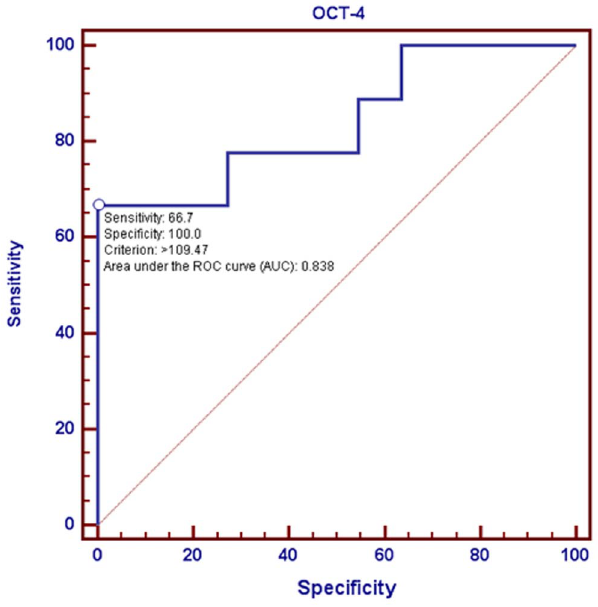
Figure 3. Correlation of immunoexpression of OCT-4 with metastasis. Receiver Operating Characteristic Curve (ROC) using the percentage of OCT-4 as a predictor of metastasis demonstrated a relatively high sensitivity (66.7%) and an absolute specificity (100%). The area under ROC Curve was 83.8%.